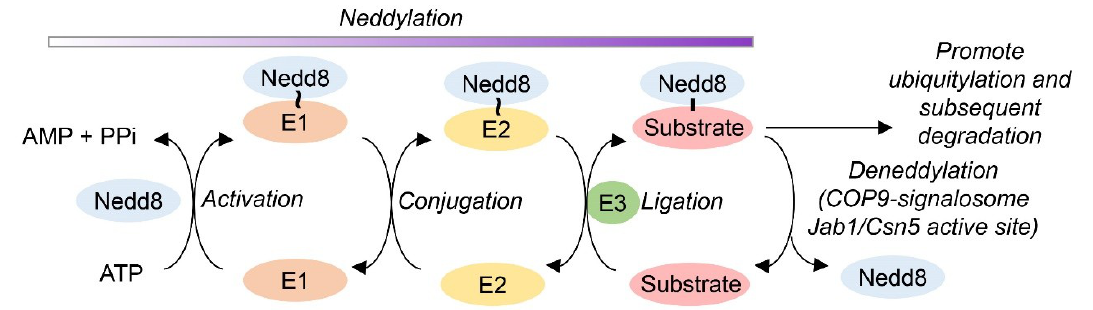
Figure 1. Post-translational modification of proteins by neddylation. The ubiquitin-like protein Nedd8 is covalently bound to substrate proteins by a cascade of E1 activating, E2 conjugating and E3 ligase enzymes through a process termed neddylation. Deneddylation regulates this process and is catalyzed by the c-Jun activation domain-binding protein-1 (Jab1)/Csn5 subunit active site of the COP9-signalosome, which cleaves the isopeptide linkage to release neural precursor cell expressed developmentally down-regulated 8 (Nedd8) from the substrate protein. ~, thioester intermediate. —, isopeptide linkage.